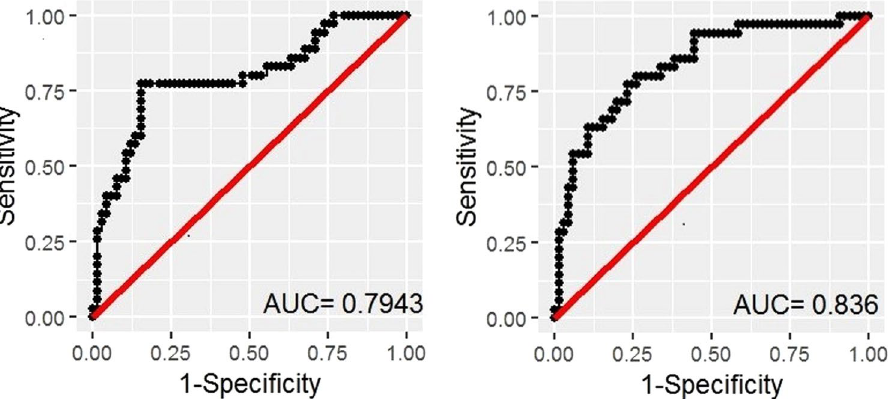
Figure 2. Receiver operating characteristic curves for the prediction of high neocortical amyloid load. Receiver operating characteristic curves of logistic regression modelling shows that the specificity of the ‘base’ model comprising major risk factors age and APOE ε 4 allele status, and gender and education ( a ) was enhanced by adding the ratio of AA:DPA i.e. ‘base + AA:DPA’ model ( b ) at 80% sensitivity. AUC: area under the curve; AA: arachidonic acid, DPA: Docosapentaenoic acid